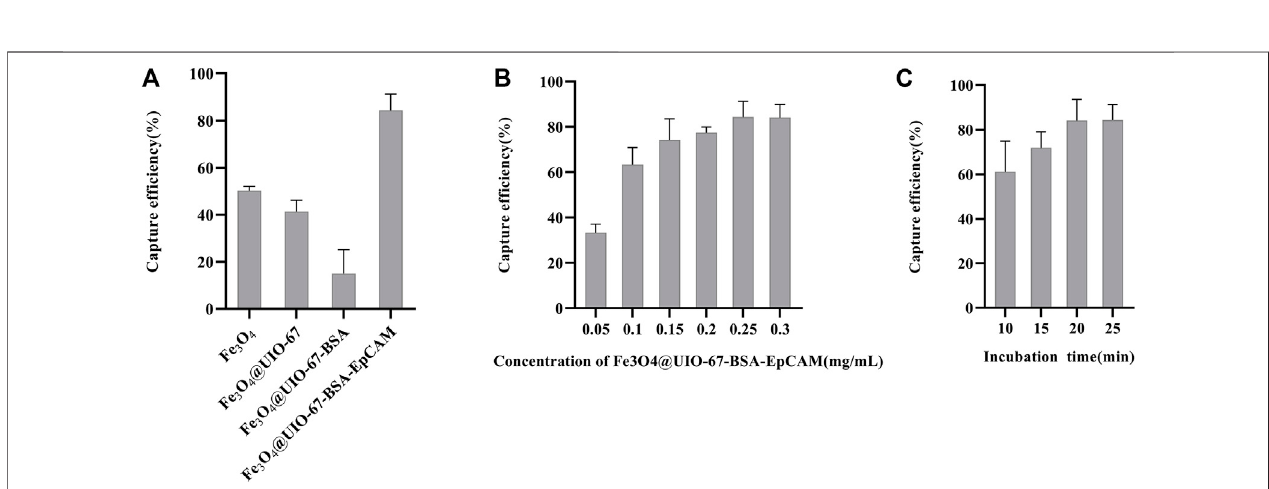
FIGURE3|(A) Analysisofthenanoparticlemodi fi cationstatusonMCF-7cellcaptureef fi ciency. (B) AnalysisoftheeffectsofnanoparticleconcentrationonMCF-7 cell capture ef fi ciency. (C) Analysis of the effects of time on MCF-7 cell capture ef fi ciency.